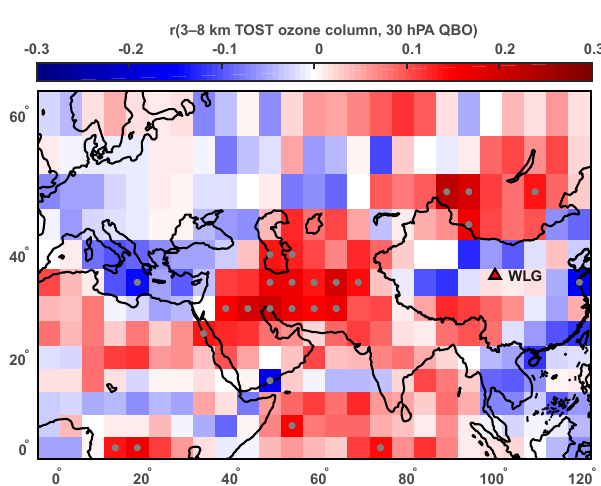
Figure 15. Correlation coefficients between the QBO index and the 3–8km TOST ozone columns. Correlations for the grids with grey dots indicating those that are significant ( p < 0 .